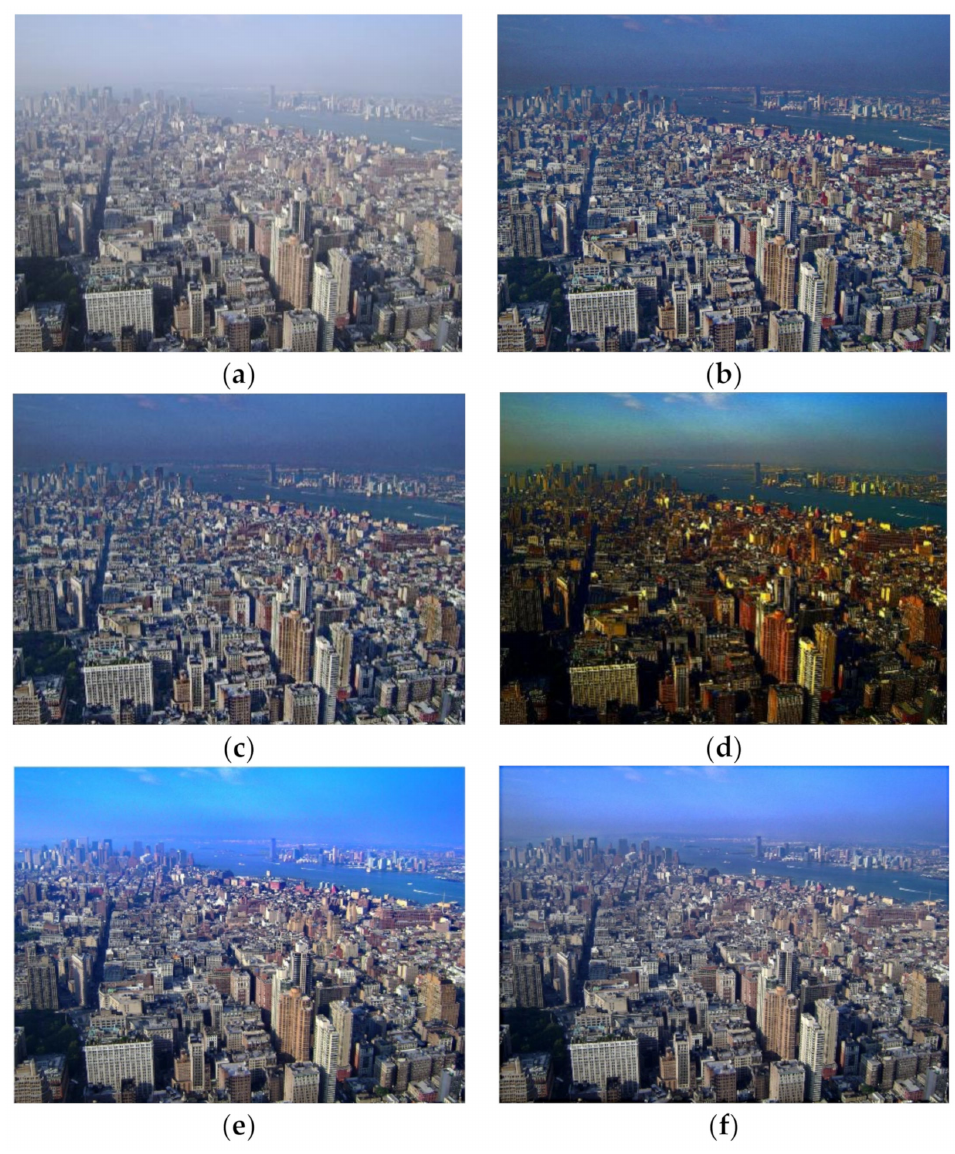
Figure 13. A comparison of defogging effects of the image of a city with fog. ( a ) Image of foggy coastal city image; ( b ) Tarel’s method; ( c ) He’s method; ( d ) Tufail’s method; ( e ) Gao ’s method; ( f ) our